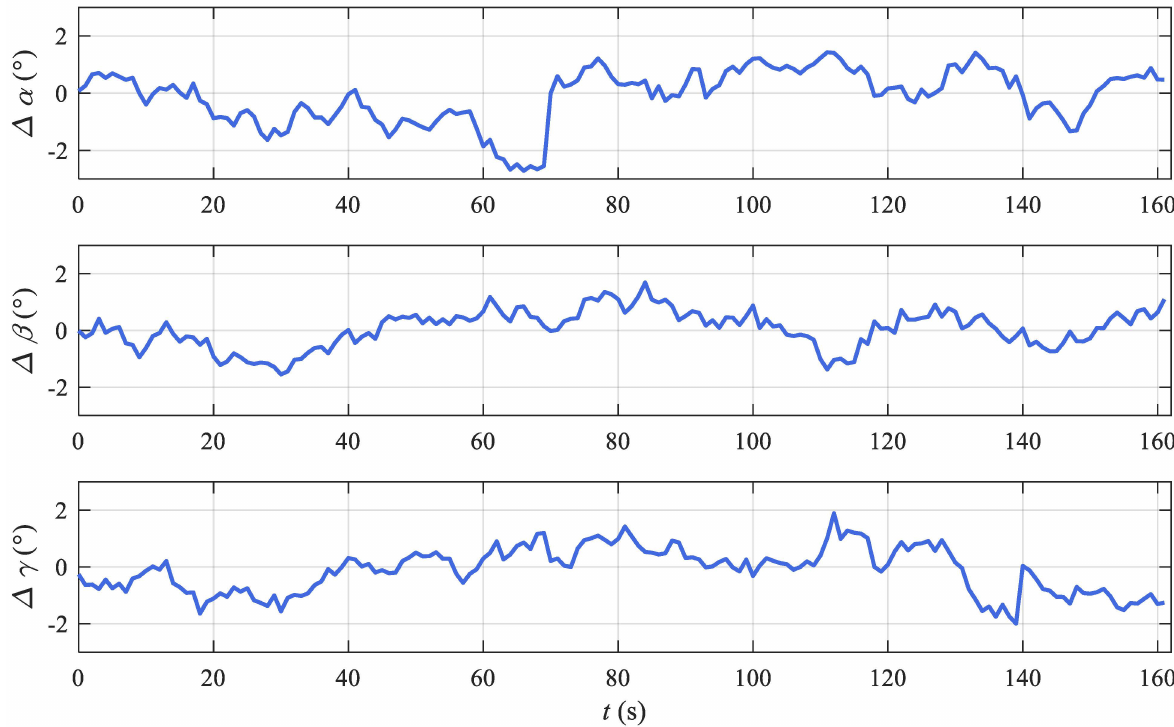
Figure 9. Error of the proposed method with ground truth in the road test.